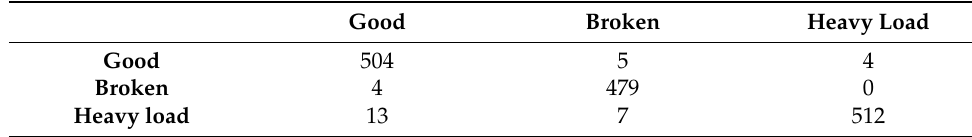
Table 6. Confusion matrix of the generated Edge Impulse